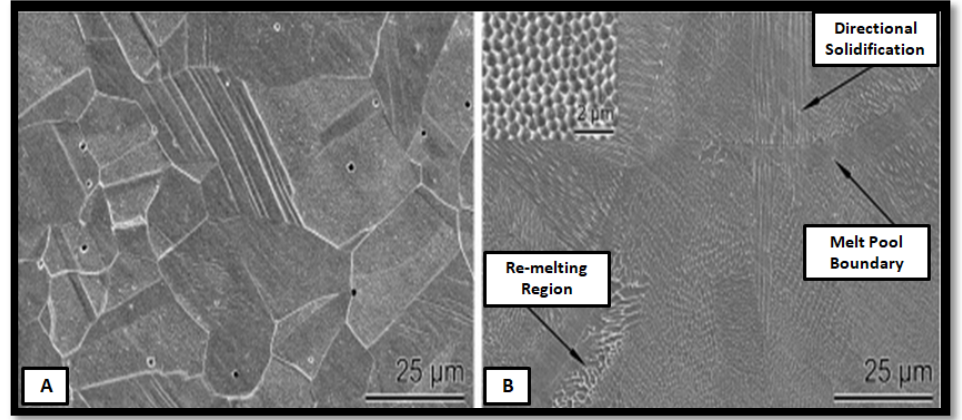
Figure 17. Microstructure of SS316L: ( A ) wrought and ( B ) AM parts [40]. Al-Mamun et al. [60] also compared the corrosion resistance of wrought SS316L, and AM builds part in the physiological environment. The AM build part shows better passive film stability, which restricts the pit formation to a higher potential of −67 mVSCE, where wrought SS316L has −204.3 mVSCE. The AM part has a refined microstructure with a